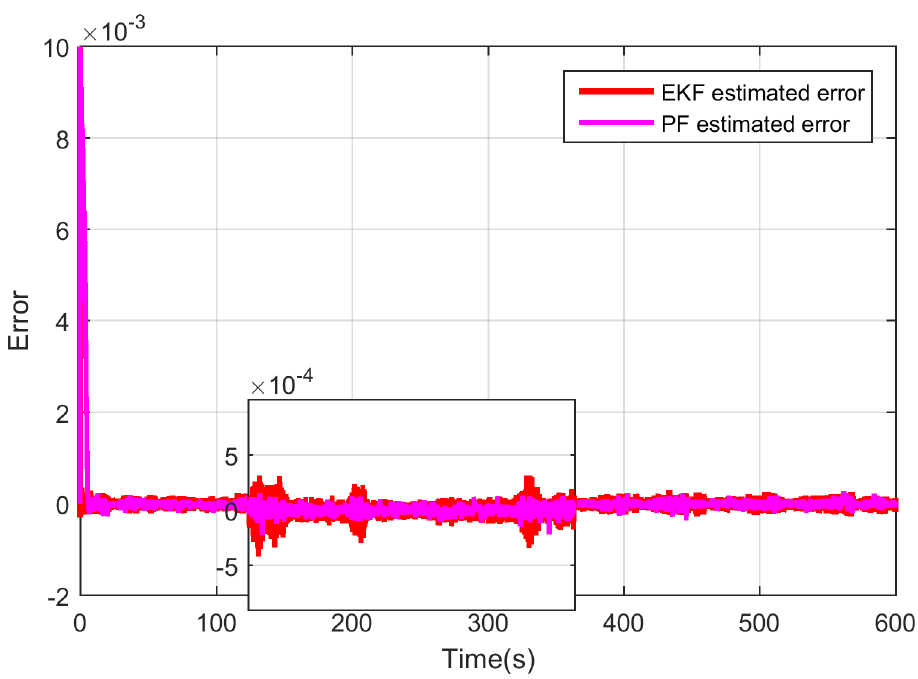
Fig 7. Errors of model predicted ammonia concentration and PF estimated ammonia concentration.